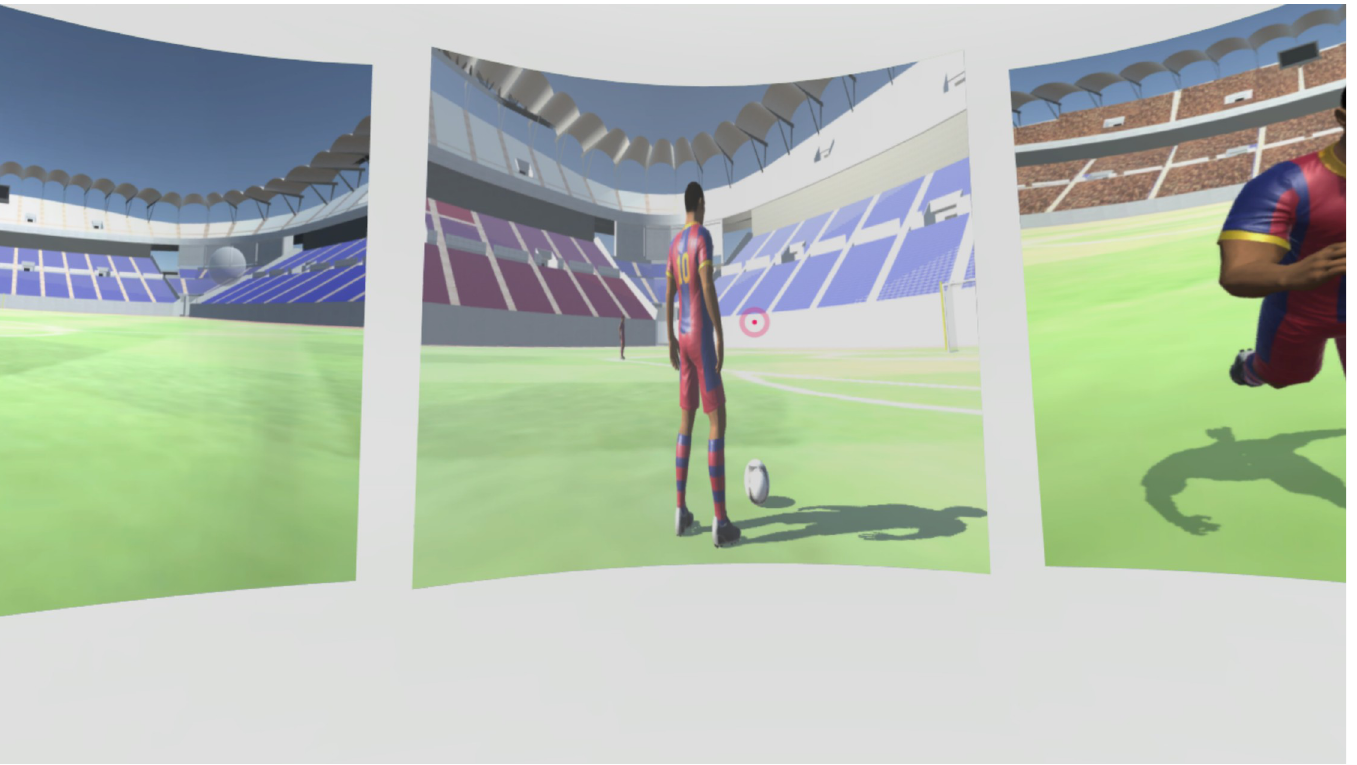
Fig 7. View of the Main Menu. https://doi.org/10.1371/journal.pone.0230042.g007 gaze and point mechanics. The center eye of HMD raycasts a small pink pointer, which acts as a visual reference to interact with virtual objects and identifies the center of their field of view (FOV). In front of the user, three scenes are displayed from left to right, which represents the order that they should access during the experiment. Fig 7 shows the user view of the Main Menu. Scene 1 is titled “Look at the Spheres” (Fig 8). It is intended to help the user acclimate to the gaze and point mechanics and become comfortable with the headset during active movement